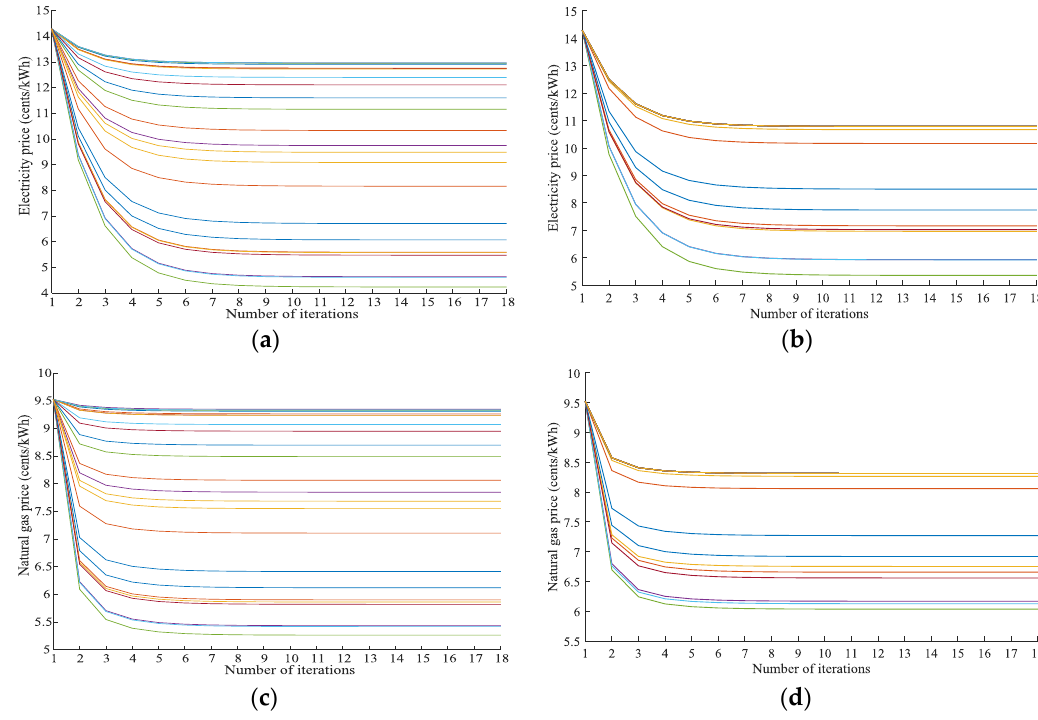
Figure 10. The convergence processes of energy prices: ( a ) The convergence processes of electricity prices without DR; ( b ) The convergence processes of electricity prices with DR; ( c ) The convergence processes of gas prices without DR; ( d ) The convergence processes of gas prices with DR.